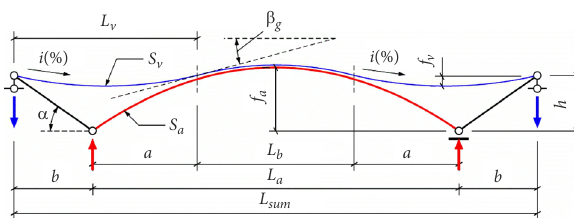
Figure 2. The main